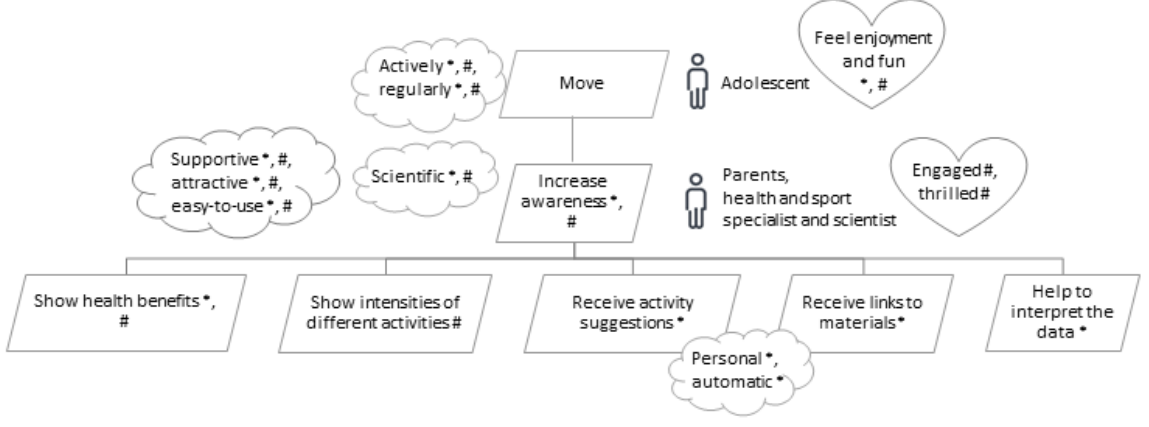
Figure 6. Sublevel models for the functional goal “increase awareness.” The “*” in the model represents findings from the literature; the “#” represents suggestions by